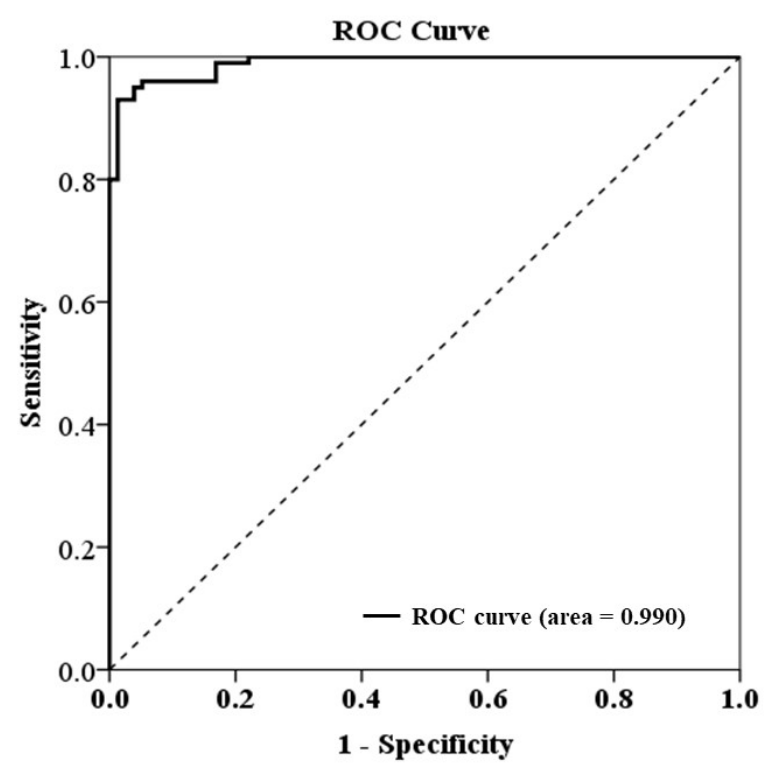
Figure 2. The ROC curve (receiver operating characteristic curve), ampullary cancer (study group) vs. healthy volunteers (normal control).